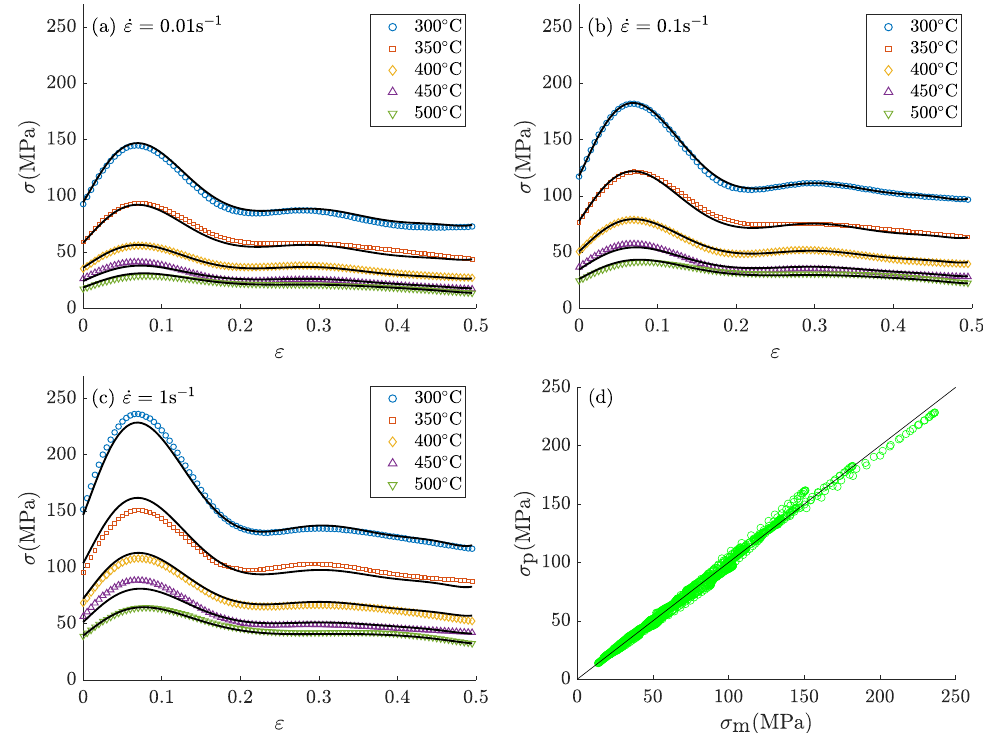
Figure 11. The results of the revised ST model with method 1. The stress–strain curves studied in this work at different temperatures and three different strain rates of ( a ) 0.01s − 1 , ( b ) 0.1s − 1 , and ( c ) 1s − 1 . The unfilled symbols and the continuous lines represent the σ m and σ p , respectively. ( d ) the correlation between σ m and σ p